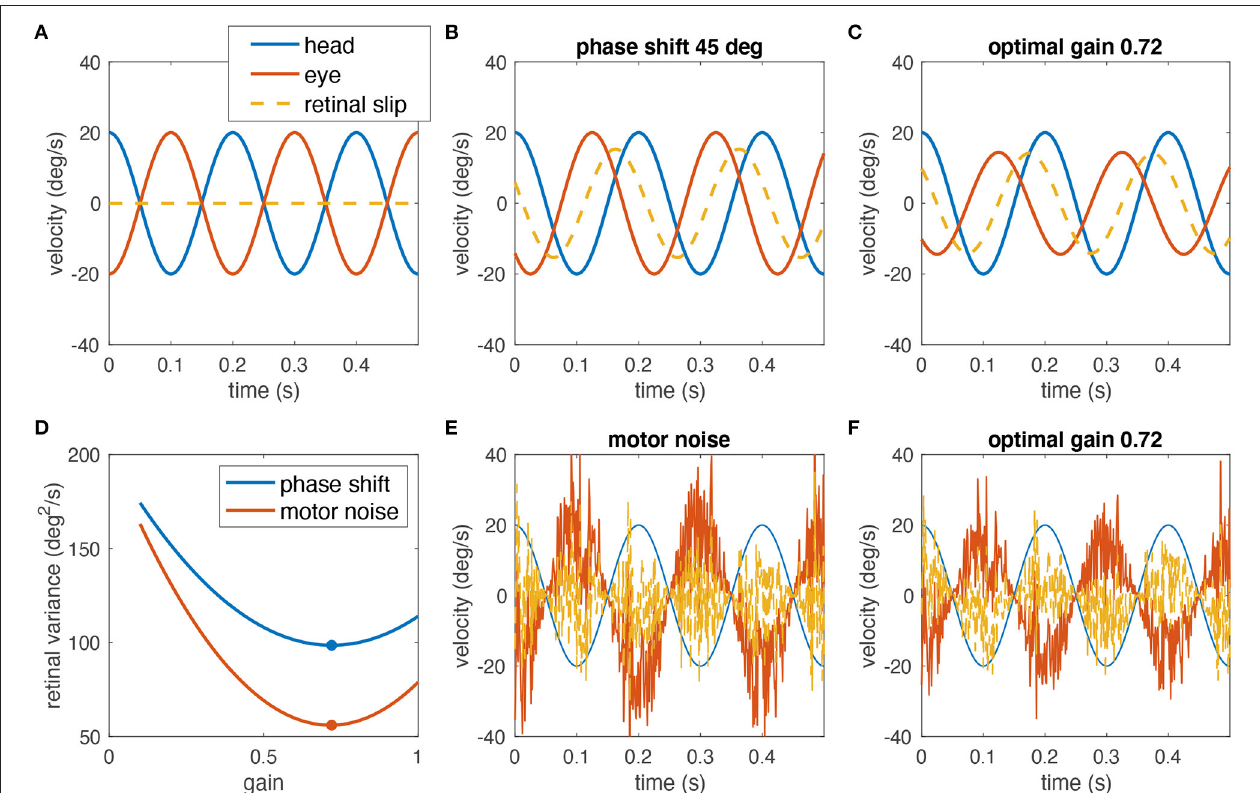
FIGURE 1 | Simulated example of why decreasing the gain of the VOR can help minimizing the retinal image slip. (A) A perfect compensatory VOR (gain = 1, no phase shift, no noise) results in zero retinal image slip (eye velocity in red, head velocity in blue, retinal image slip in dashed yellow). (B) In the presence of a 45 ◦ phase shift between eye and head rotation, a strong retinal image slip is present despite a gain of 1. (C) Reducing the VOR gain to 0.72 minimizes the overall retinal image slip. (D) Variance of the retinal slip plotted with respect to the VOR gain for phase shifts as in (B,C) (blue), and noise as in (E,F) (red). The plots have been obtained from numerical simulations. The optimal gain in both cases is ∼ 0.72 (red and blue dots). (E) Signal-dependent motor noise, proportional to eye velocity introduces a strong retinal image slip even if the gain = 1. (F) Reduction of the VOR gain also reduces the motor noise and thus the overall retinal image slip; retinal image slip plotted with respect to the VOR gain for this example is shown in (D) (red